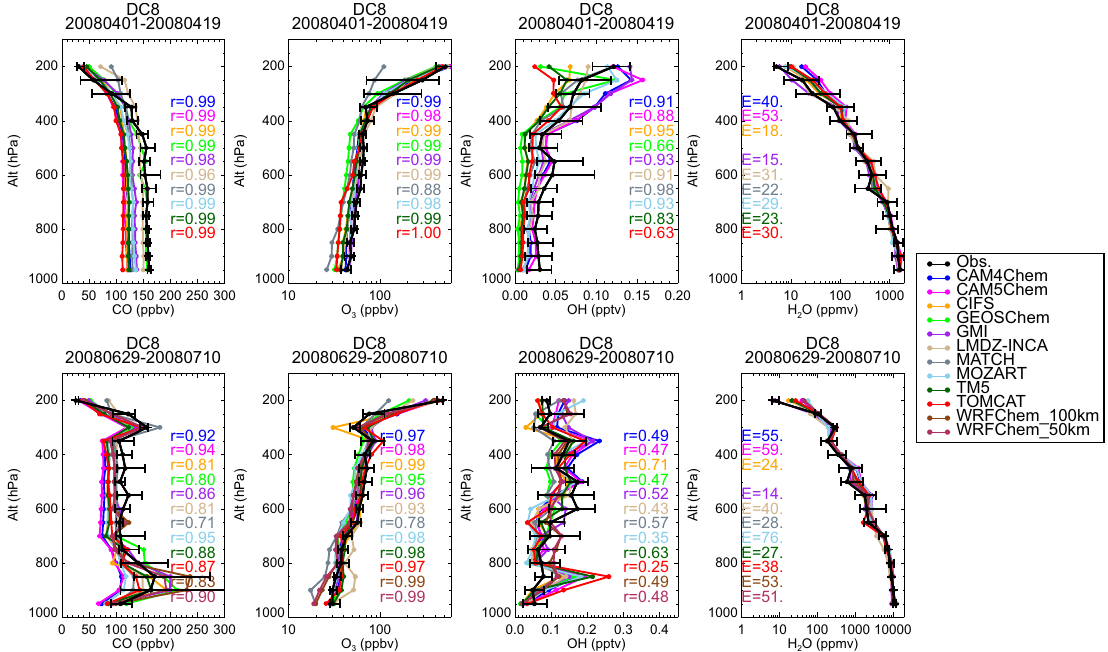
Figure 7. DC8 vertical profiles from the spring ARCTAS-A (top) and summer ARCTAS-B (bottom) campaigns in 2008. Median concen- trations of CO (left), O 3 (middle), OH (middle) and H 2 O (right), with error bars showing the 25th and 75th percentiles of the observations. Pearson’s correlation coefficients are shown for CO, O 3 and OH. NMGE (%) is shown for H 2 O. (N.B. due to missing data in the GEOS- Chem hourly files, the median concentrations in the 200, 250 and 300hPa bins have been calculated over 463 data points instead of 678 data points which are used for the other models and